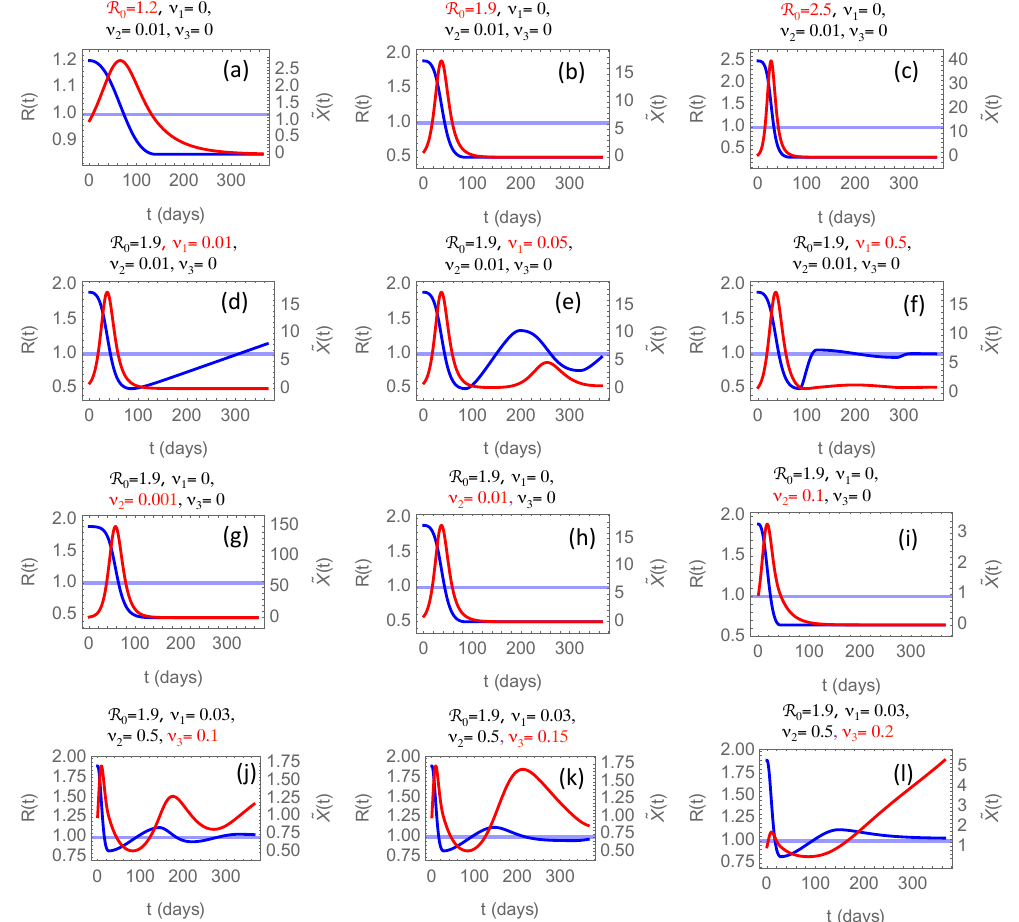
( t ) and red curves ˜ X ( t ) as solutions of Equations (13) and R